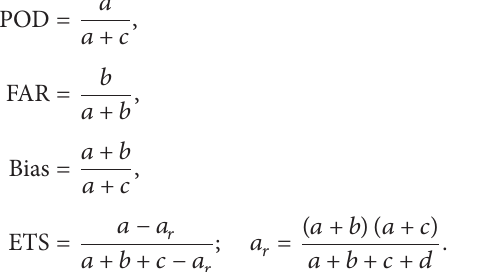
Figure 11: Precipitation scores for the whole period (1 December 2012–30 November 2013) for the daily precipitation thresholds: 0.2, 1, 5, 10, 20, 40, and 60mm. A = Bias, B = ETS, C = POD, and D =